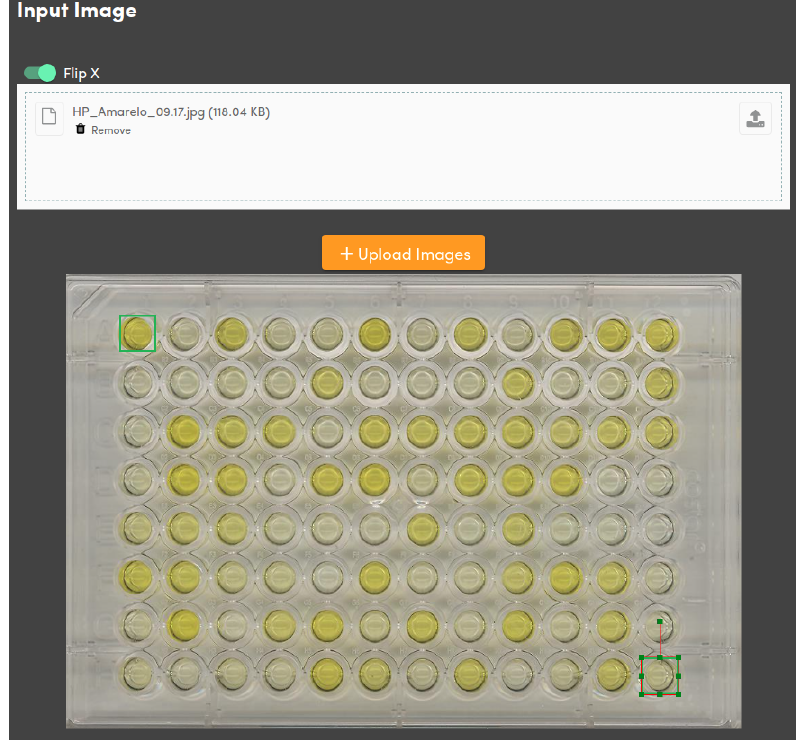
Figure 11. Upload and bounding boxes’ location for the two bounding box well detection method.